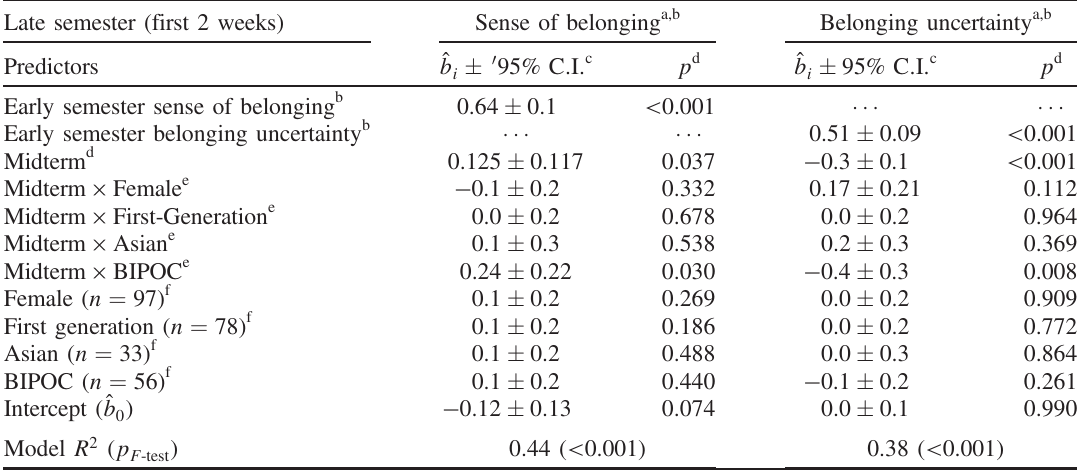
TABLE VI. Late-semester social belonging multiple regression